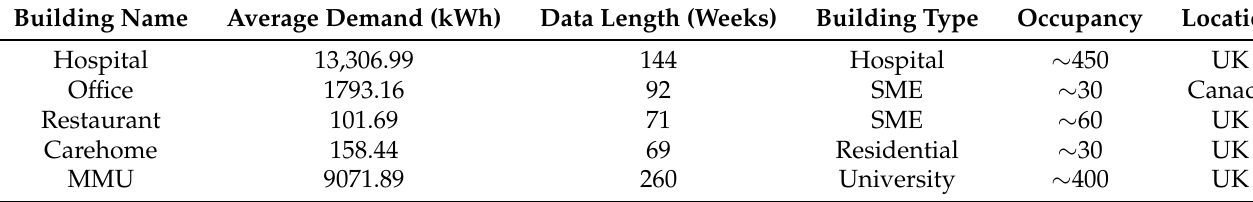
Table 2. Dataset demography.